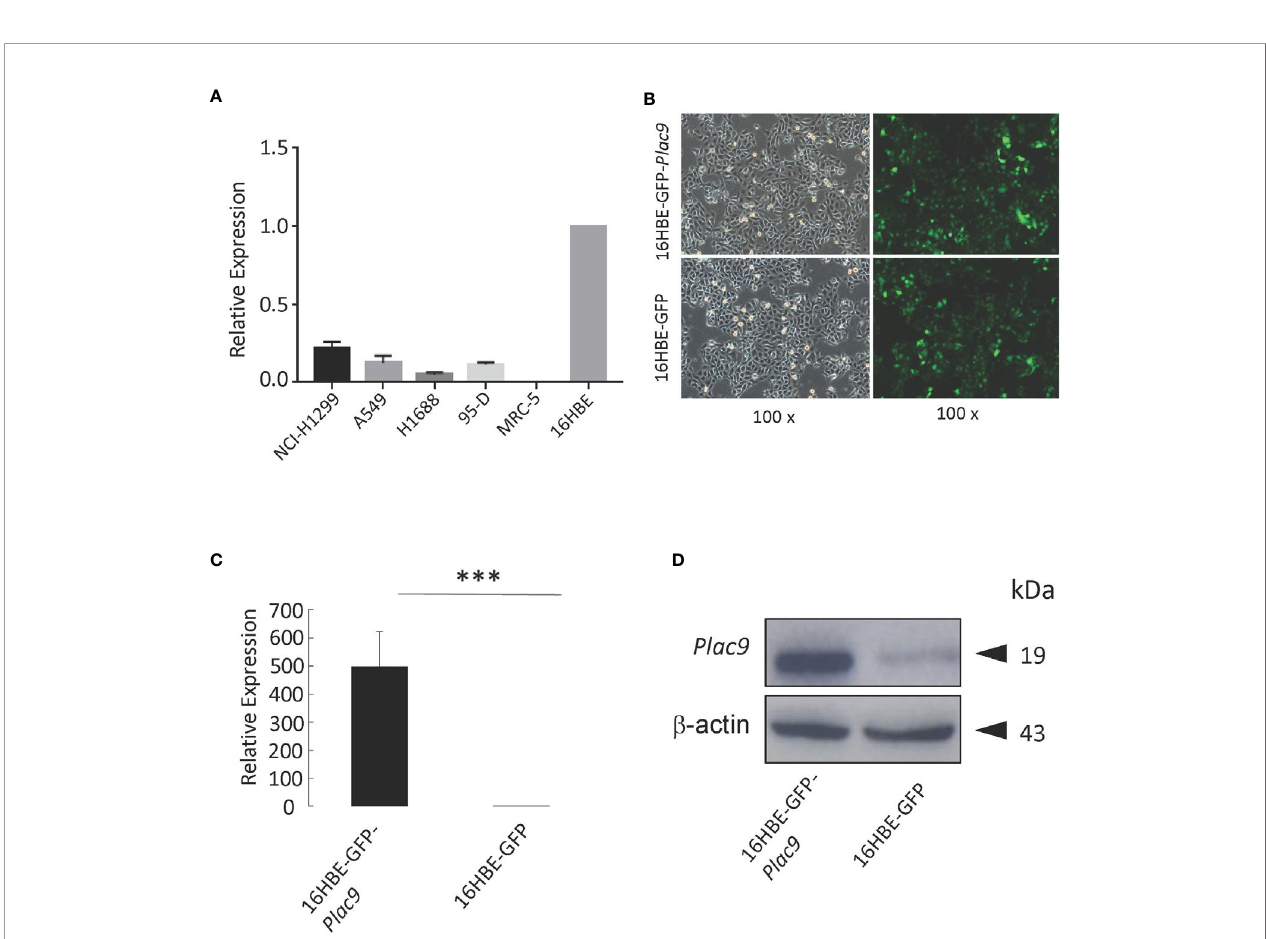
FIGURE 2 | Construction of stable PLAC9-expressing 16HBE cells via lentiviral transduction. (A) Relative PLAC9 mRNA expression levels in the human lung cell lines NCI-H1299, A549, H1688, 95-D, MRC-5, and 16HBE. (B) 16HBE was used to generate stable cell lines expressing GFP (16HBE- GFP ) or both GFP and PLAC9 (16HBE- GFP - Plac9 ). Detection of GFP in stable cell lines 16HBE- GFP - Plac9 and 16HBE-GPF using fl uorescence microscopy (green, GFP; 100× ampli fi cation). Left panel: bright fi eld. Right panel: dark fi eld. (C) Reverse transcription quantitative PCR analysis of PLAC9 expression levels shows overexpression of PLAC9 mRNA in the stable cell line 16HBE- GFP - Plac9 compared to the control line 16HBE- GFP (*** p value < 0.001). (D) Western blot analysis shows overexpression of PLAC9 protein in the stable cell line 16HBE-GFP- Plac9 compared to the control.